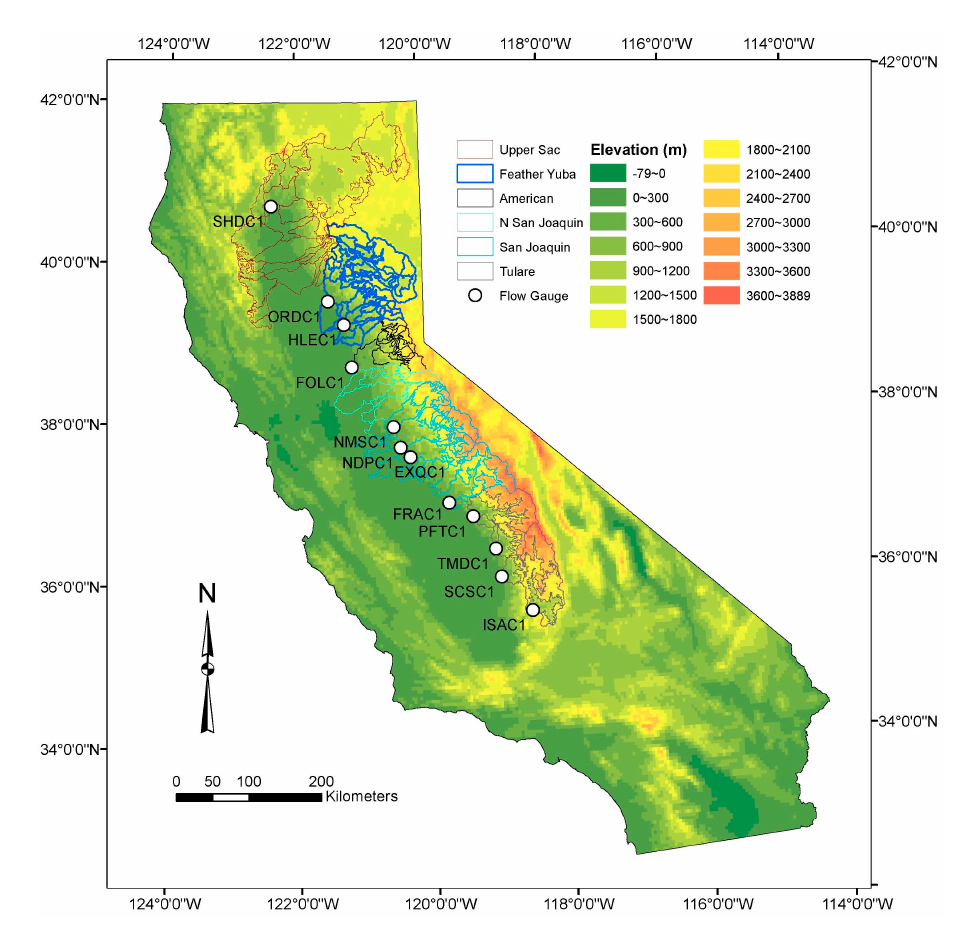
Figure 1. Location map showing study regions, basins, and reservoirs in the Central Valley of California.